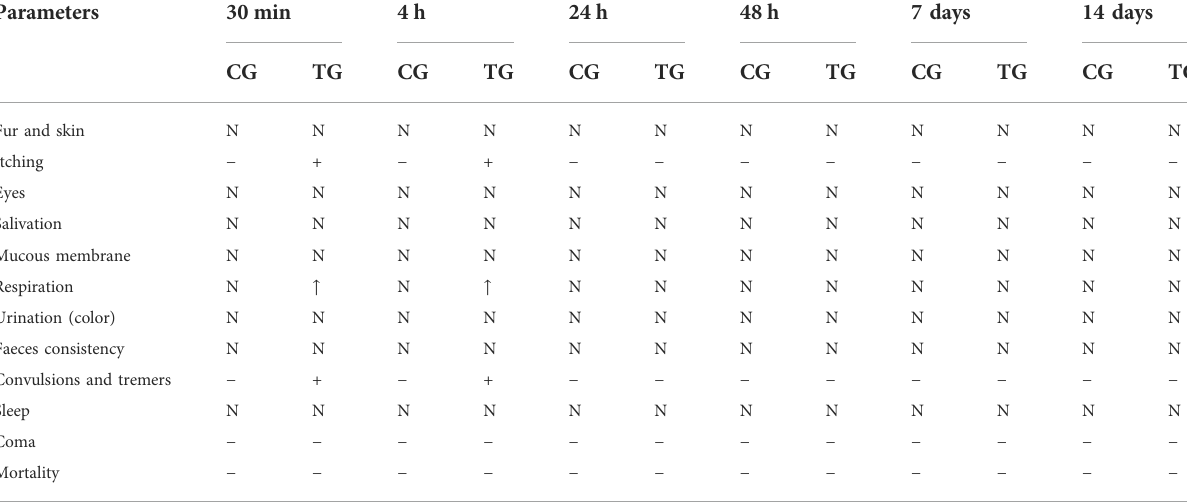
TABLE 4 Behavioral patterns of rats in bergapten-treated (2000 mg/kg p.o.) and control groups. Parameters